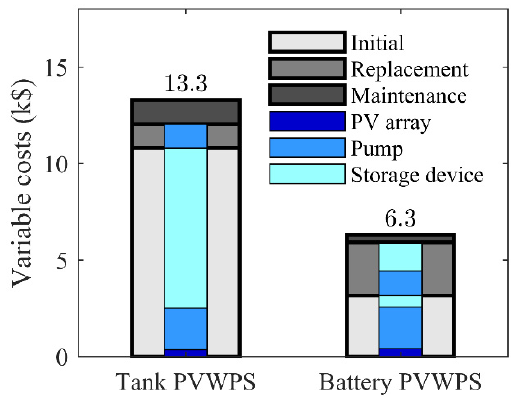
Figure 5. Breakdowns of variable costs of both optimized architectures.